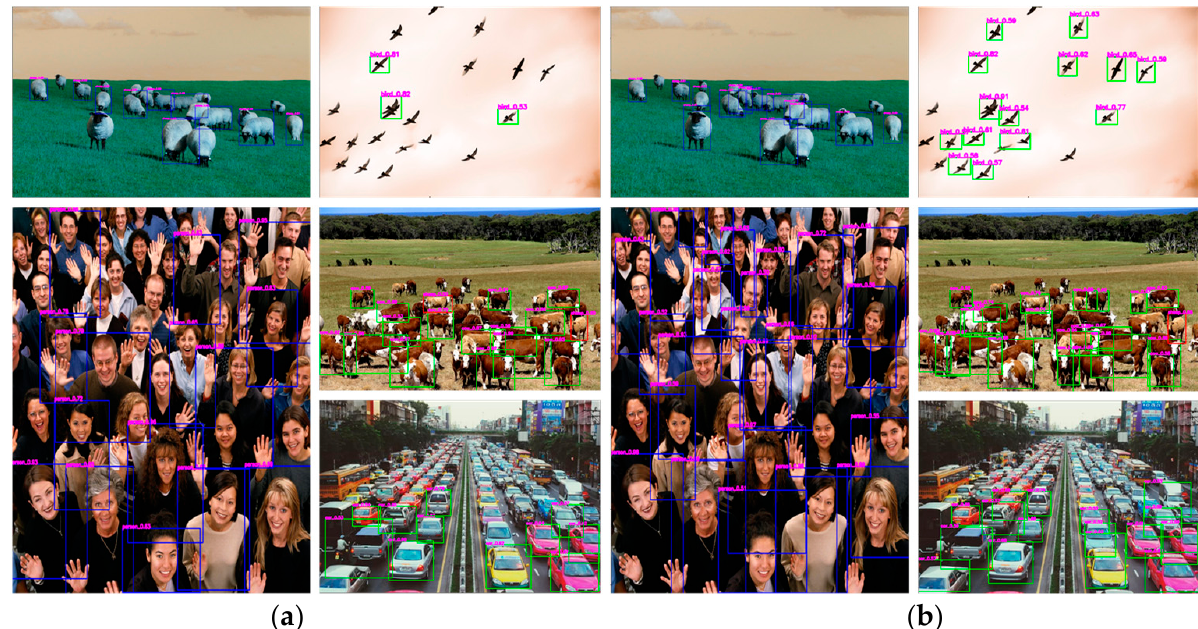
Figure 10. Testing dense target images: ( a ) on the left is use of the SSD; ( b ) on the right is use of the ADSSD.